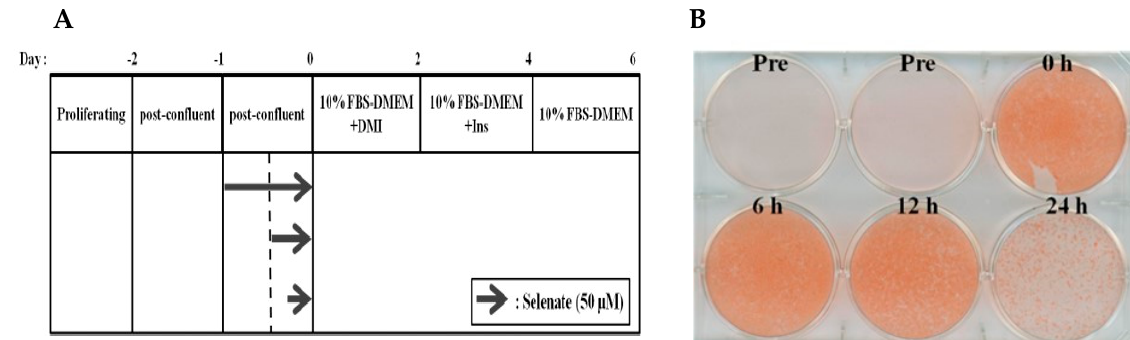
Figure 1. Selenate pretreatment inhibits adipogenesis of 3T3-L1 cells. ( A ) One-day post-confluent 3T3- L1 preadipocytes (Pre) were pretreated 50 μ M selenate for 0, 6, 12, and 24 h, and were differentiated until Day 6 without selenate treatment. ( B ) Oil Red O staining of cells was done to determine the accumulated lipid droplets.